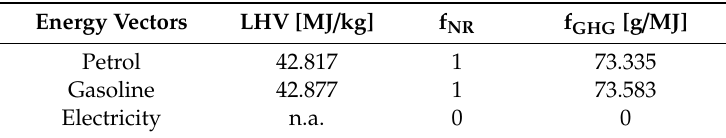
Table 2. Low heating value (LHV), non-renewable primary energy consumption factor (fNR), and greenhouse gas (GHG) emission factor (fGHG) of the energy vectors used.